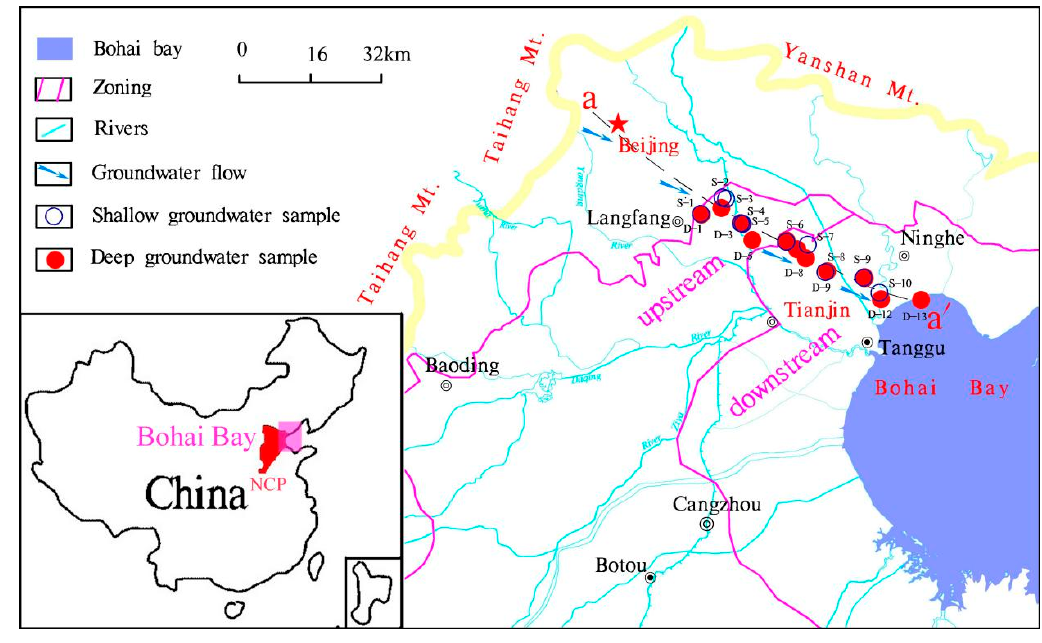
Figure 1. Study area and sampling locations.